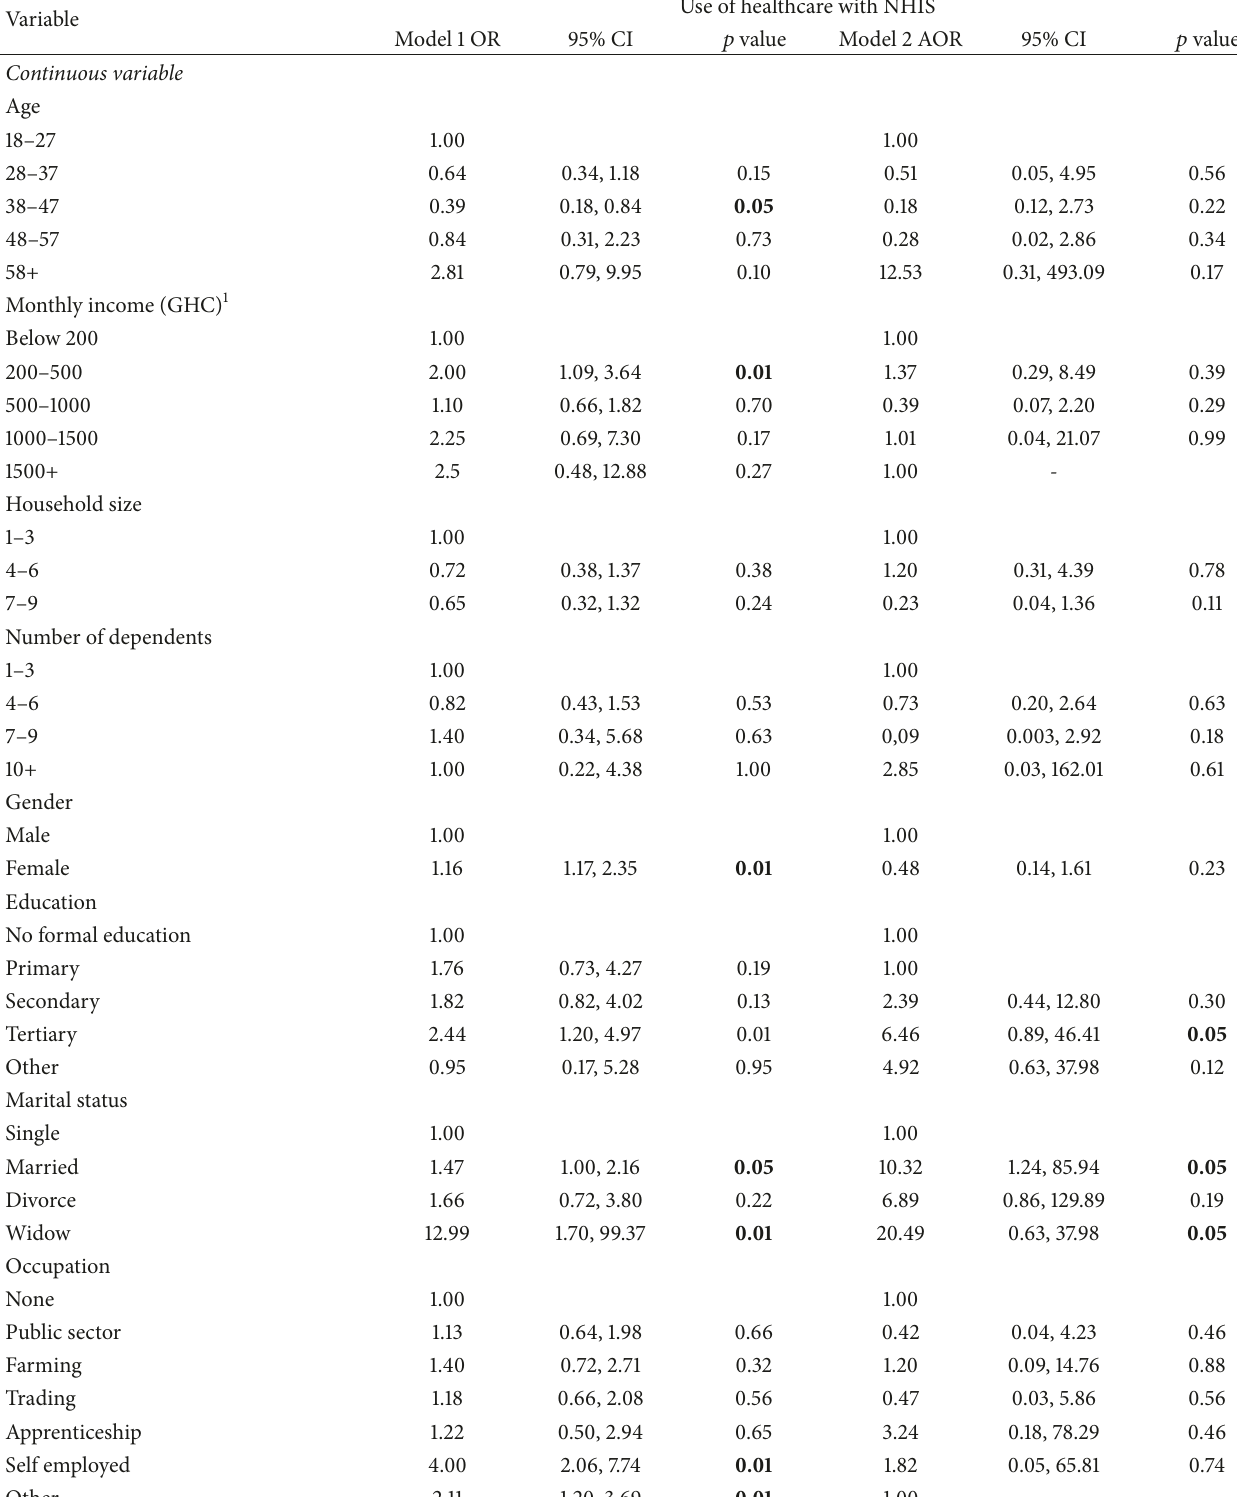
Table 3: Logistic regression analysis of households’ profile and healthcare